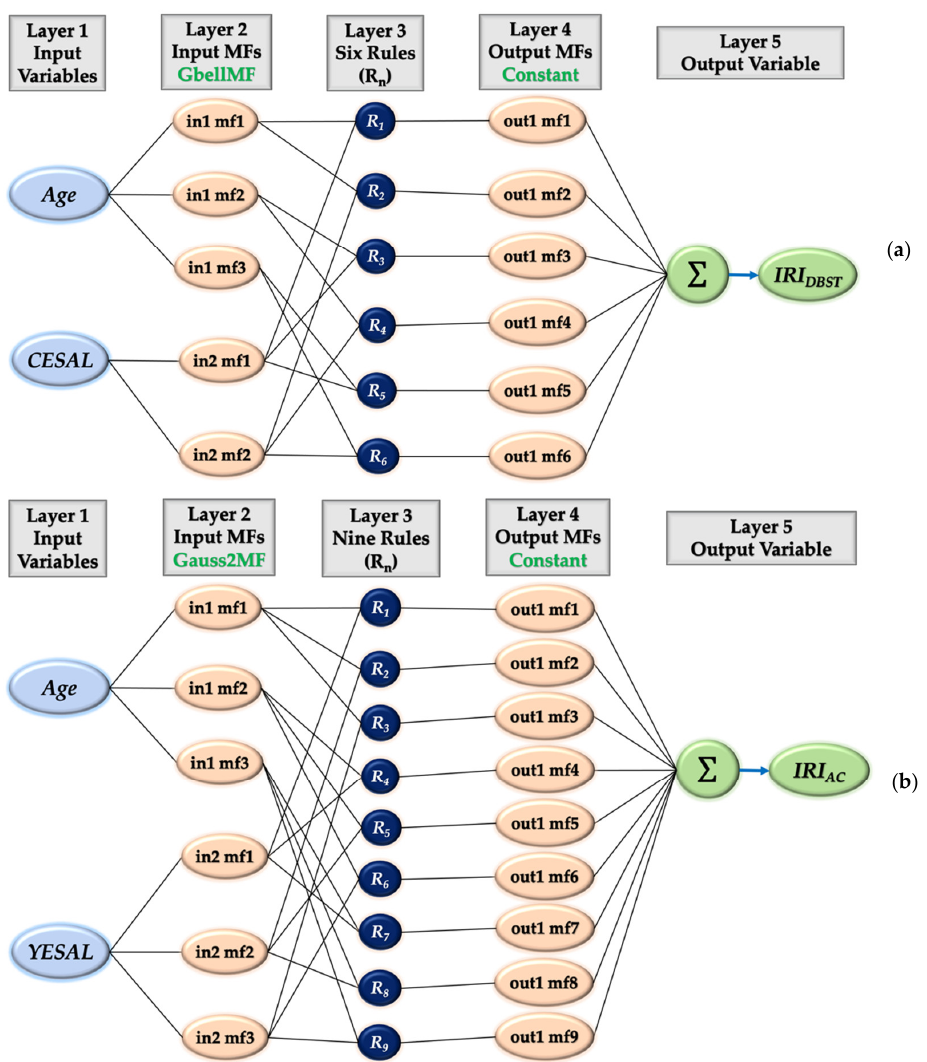
Figure 5. ANFIS model structure for the ( a ) DBST and ( b ) AC pavement sections. The selection of the optimum epoch number is a very significant factor in ANFIS modeling. Increasing the epoch number does not always mean enhancing the performance of ANFIS modeling. Usually, the modeling errors decrease by increasing the epoch number to a point, and then the errors increase afterward. Identifying this point is a necessity in ANFIS modeling. training and checking the proposed model. Epochs are the number of learning cycles where rules were adjusted to minimize the difference between the measured and the predicted IRI .